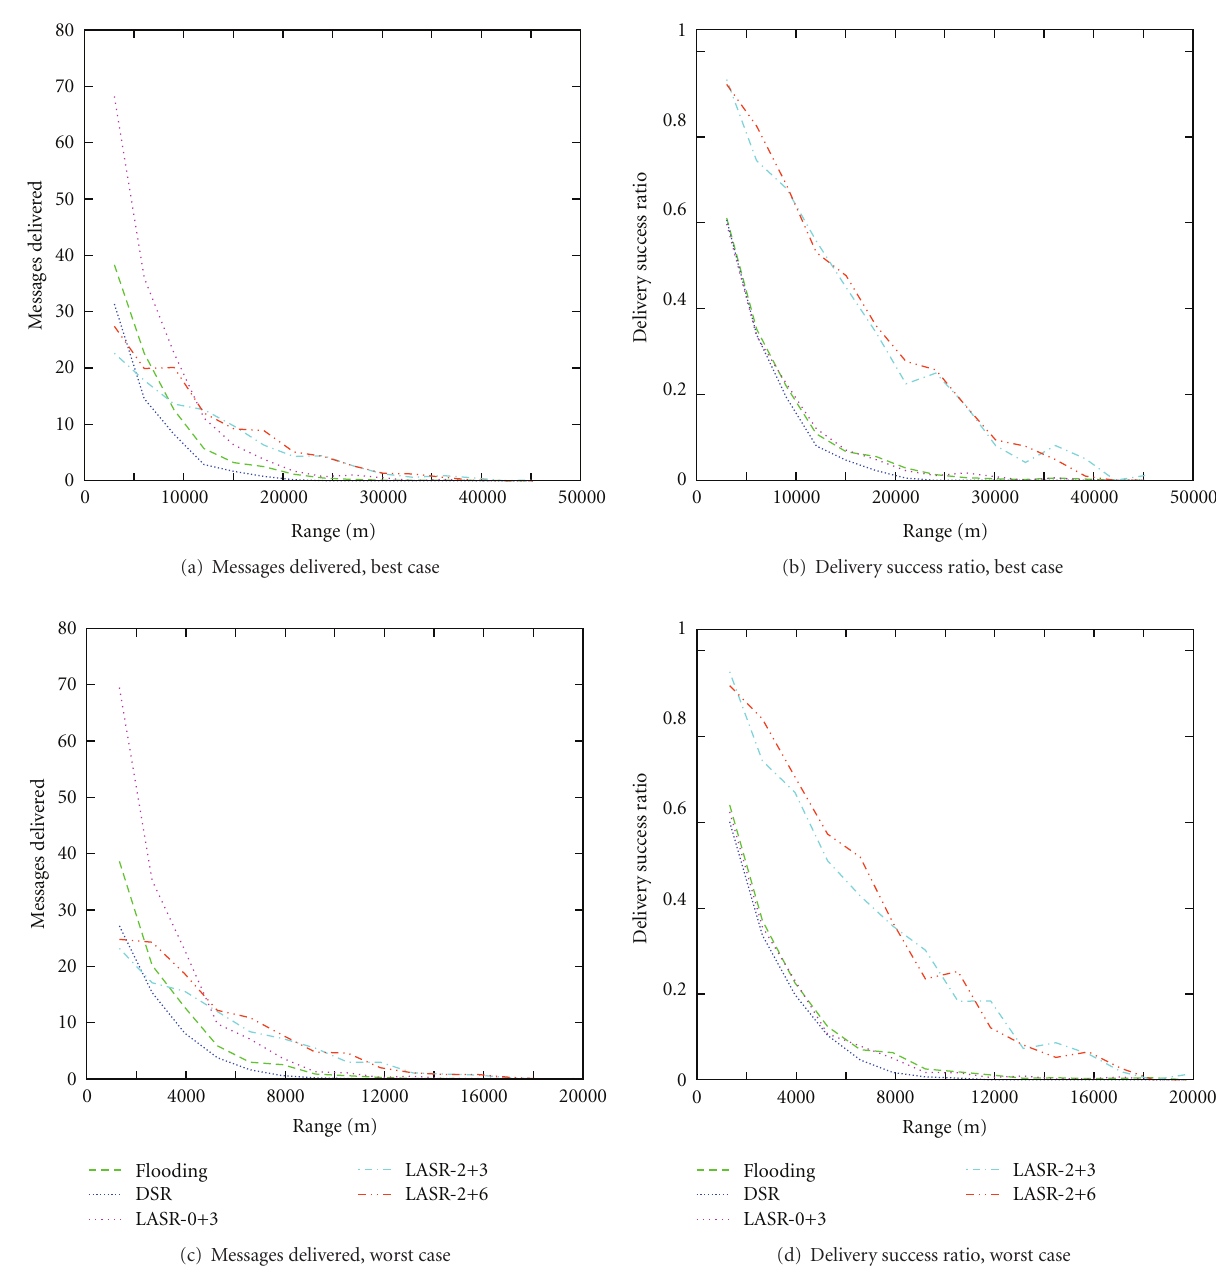
Figure 5: Messages delivered and message success: 16-vehicle line, FER NN = 0 .